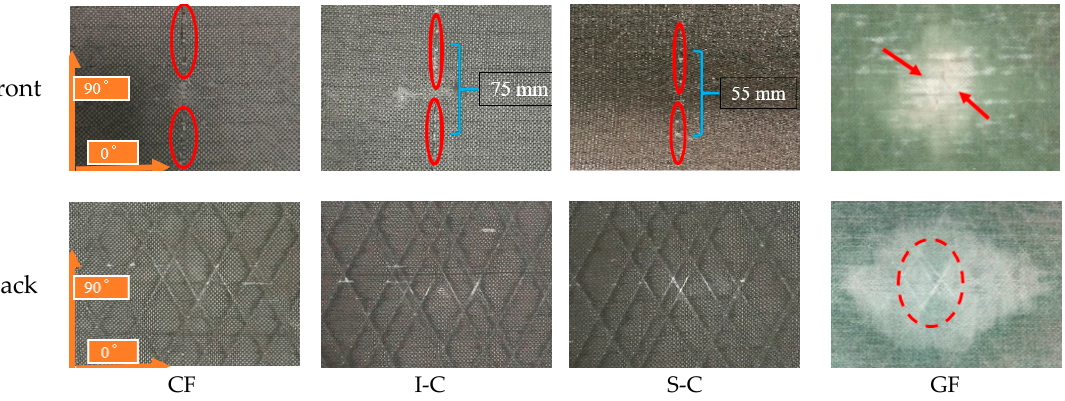
Figure 6. Front and back view photographs of composite specimens after impact at 50 J.